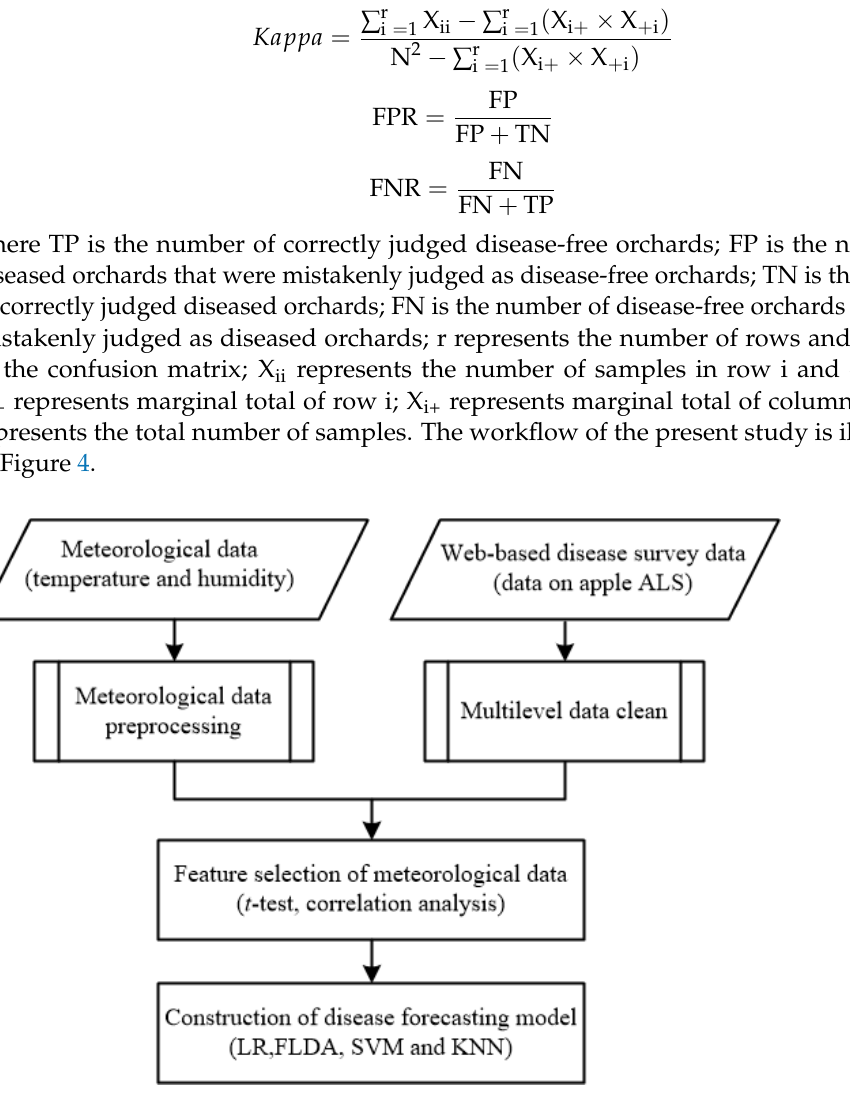
Figure 4. Workflow of data processing and constructing of disease forecasting model.